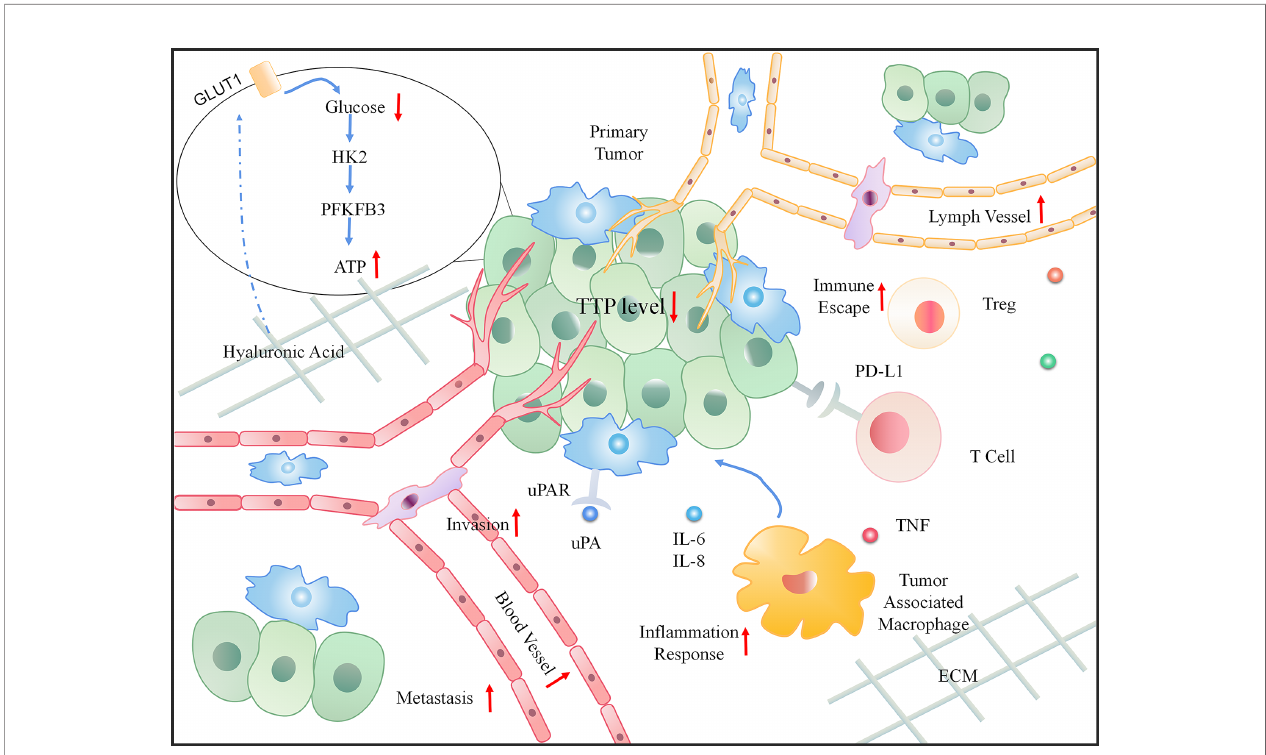
FIGURE 4 | The dynamic change in the tumor microenvironment (TME) when TTP is downregulated. When TTP expression decreases in tumor cells, the primary tumor invades the basement membrane. Moreover, an increased number of blood and lymph vessels aids tumor metastasis. In the microenvironment, the increasing in fl ammatory response, immune escape, and energy also provide a favorable environment for tumor